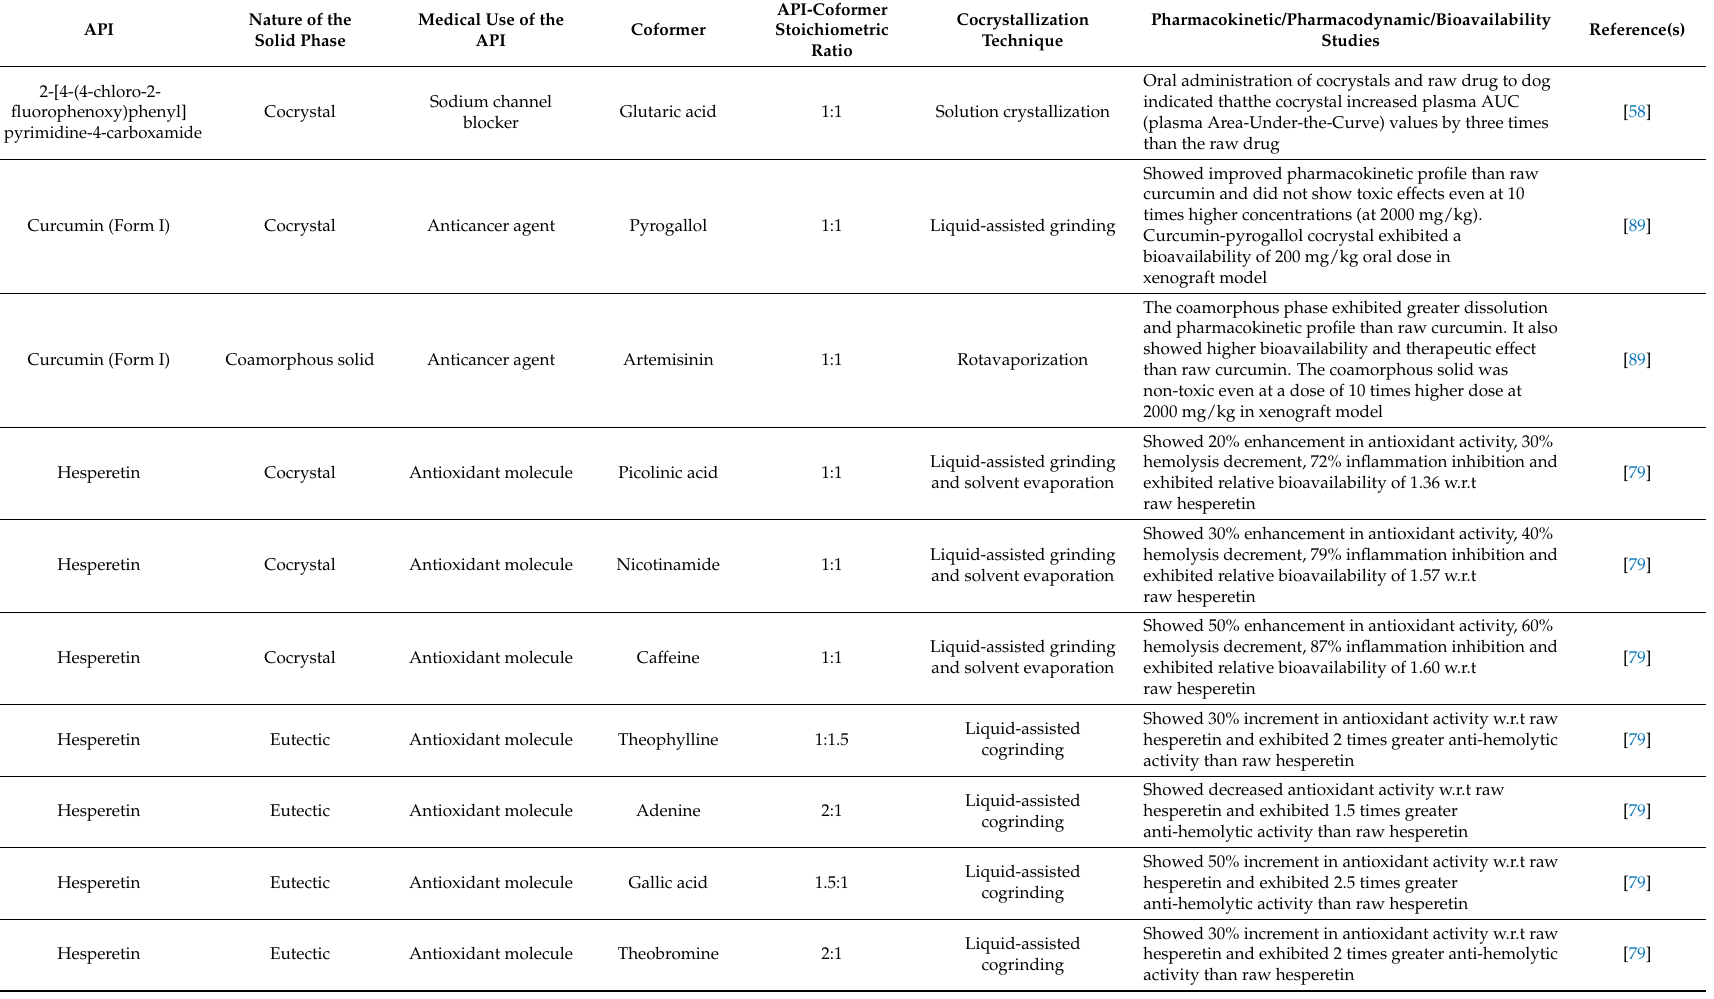
Table 13. Summary of a few literature reports on bioavailability of pharmaceutical cocrystals/eutectics/coamorphous